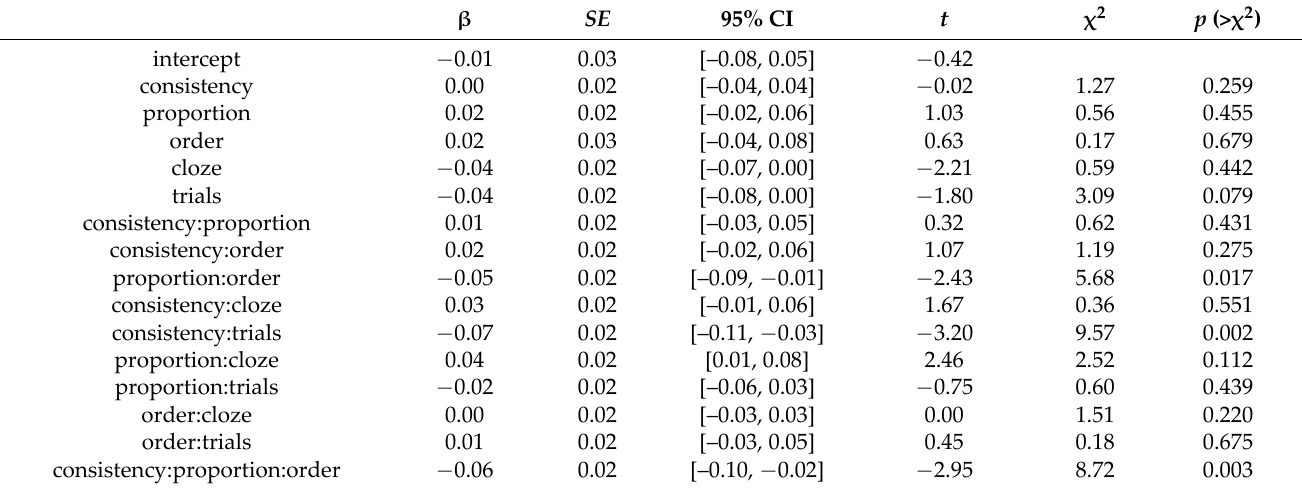
Table 6. Estimates of fixed effects and analysis of deviance (Type II Wald chi‑square tests) for the LN (650–1000 ms) time window for models that included trials as a